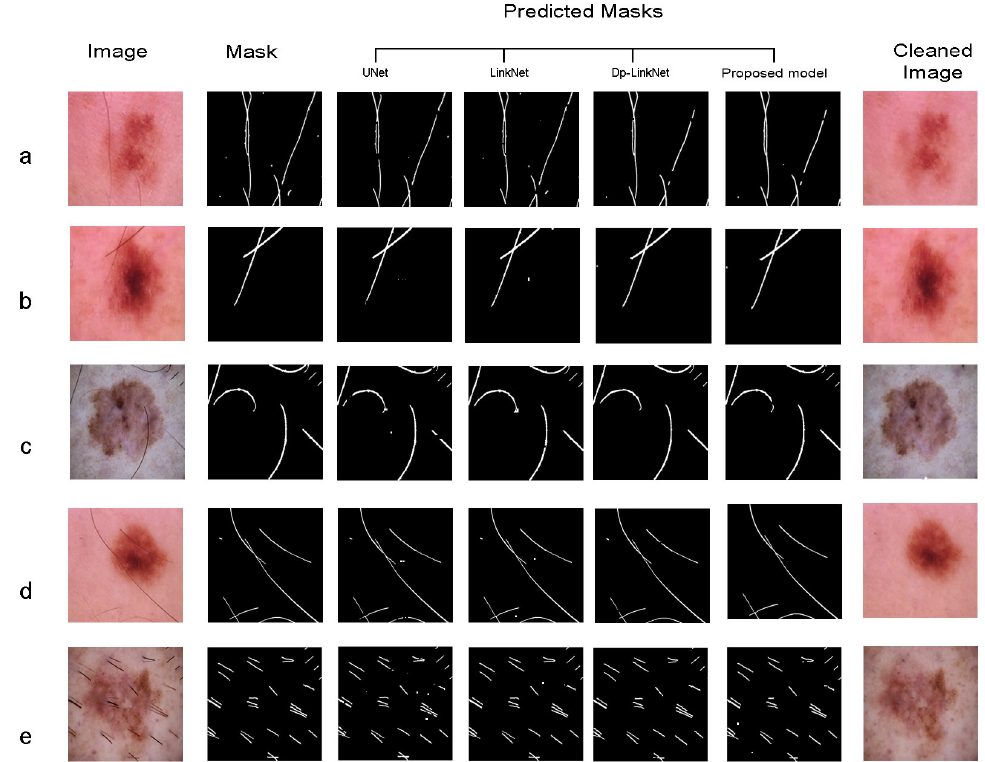
Figure 9. Comparison of models in the noise removal phase.